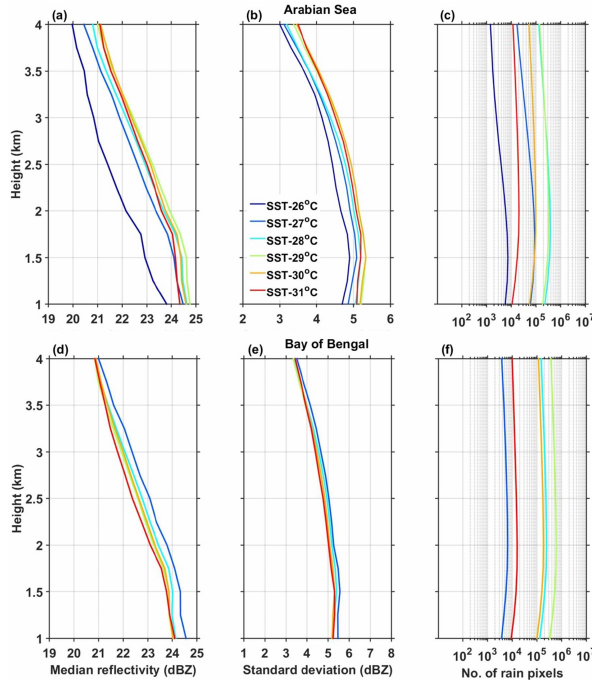
Figure 3. (a) and (d) and (b) and (e) represent vertical profiles of median reflectivity corresponding to deep systems and their stan- dard deviation (in dBZ) with SST over the AS and the BOB, re- spectively, during the ISM season. (c) and (f) show the number of conditional reflectivity pixels at each altitude used for the estimation of the median and standard deviation.